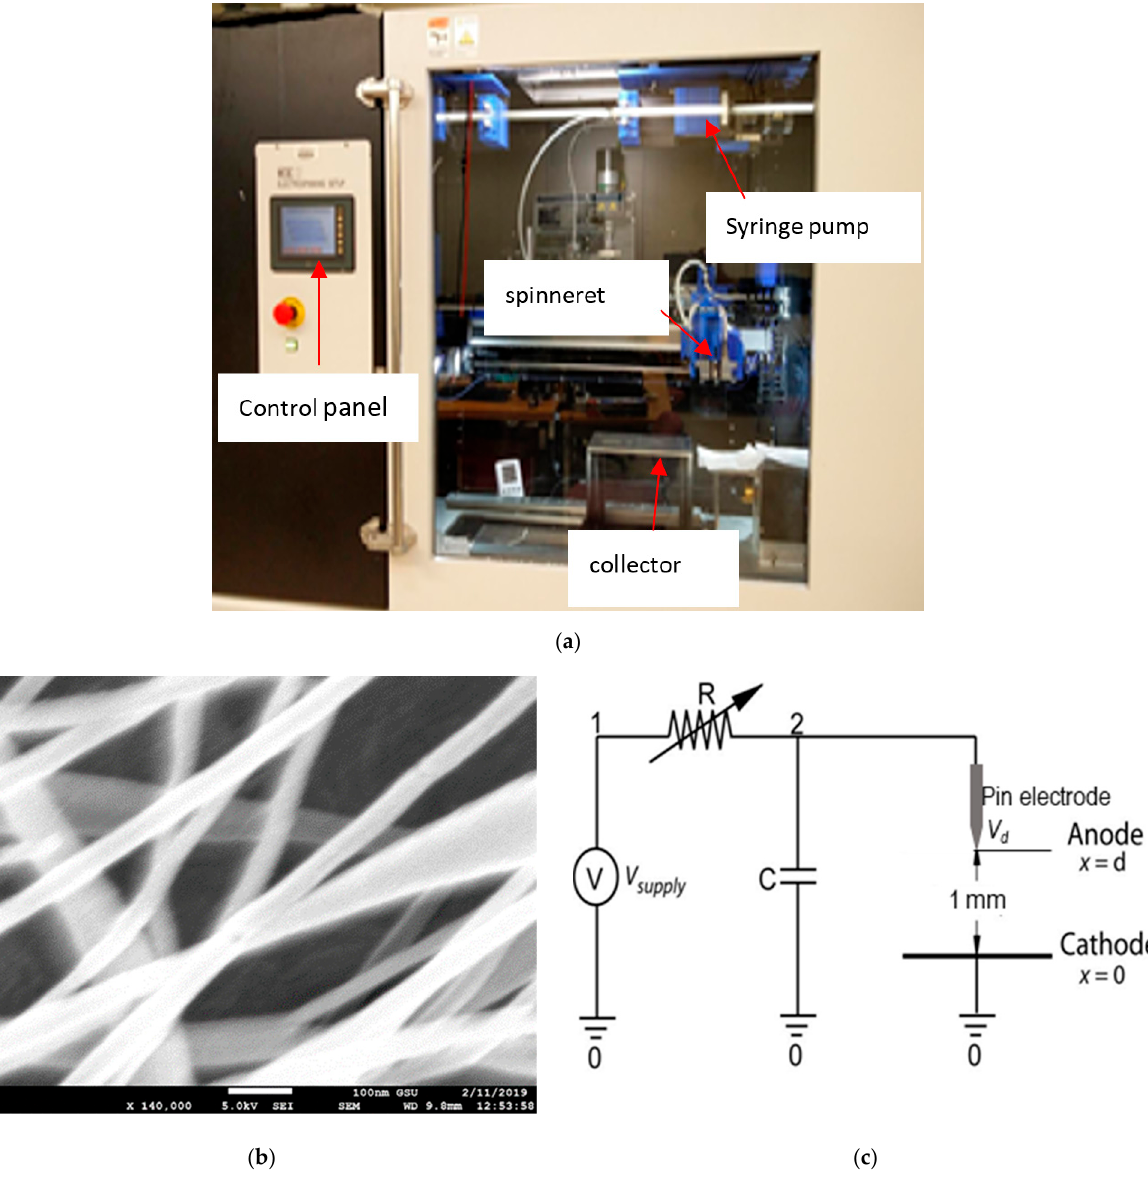
Figure 1. ( a ) Picture of the electrospinning unit ( b ) SEM image of PVDF nanofiber ( c ) schematic of the pin to plate plasma discharge driving circuit, with numbers representing the different circuit the nodes. V s : Power supply, connecting node 1–0. R: Resistor, connecting node 1–2 (3 M Ω ). C p : Parasitic capacitance, present intrinsically in the system due to external cables and connections. V d : Plasma discharge, connecting node 2–0.